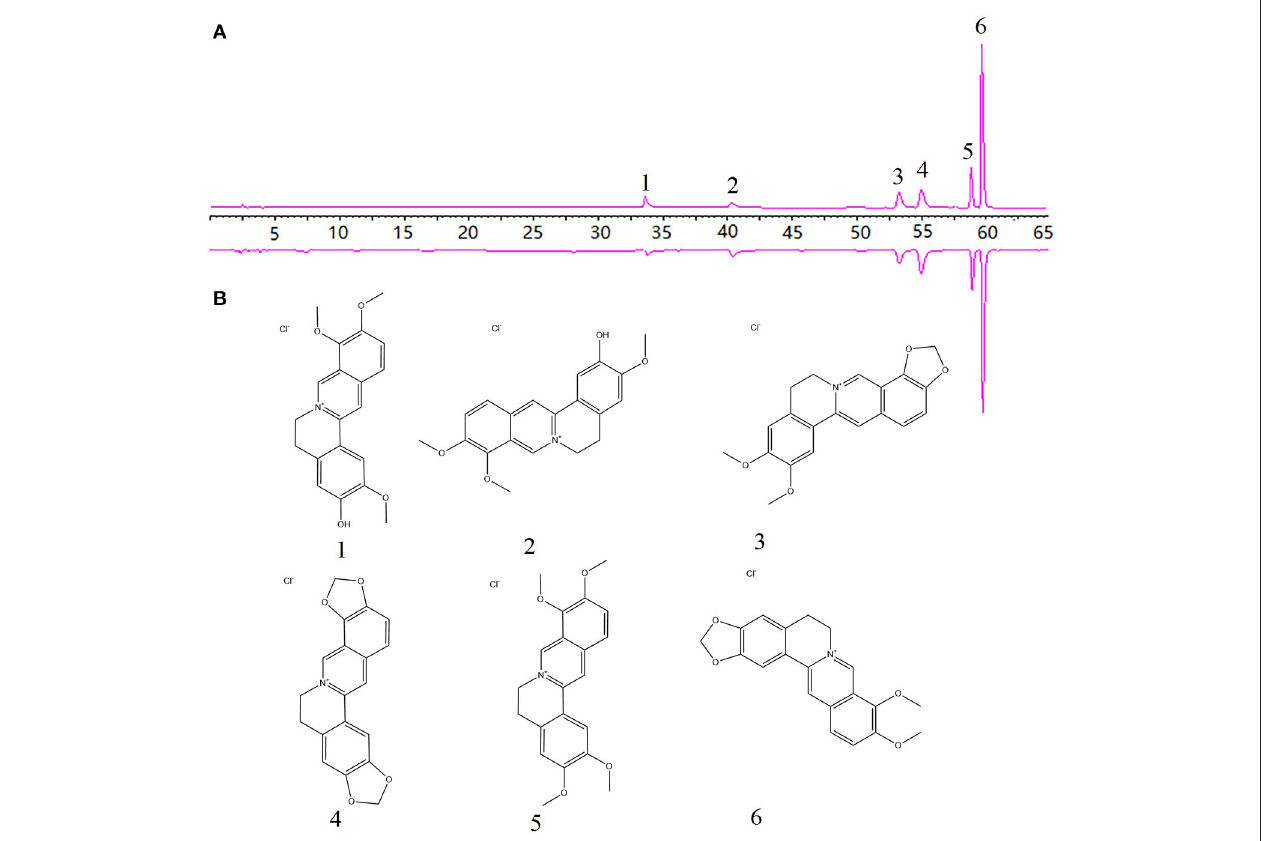
FIGURE 2 | The chromatogram of 6 alkaloids from CR. (A) Reference solution. (B) Coptidis Rhizoma. (1 Jatrorrhizine hydrochloride; 2 Columbamine hydrochloride; 3 Epiberberine hydrochloride; 4 Coptisine hydrochloride; 5 Palmatine hydrochloride; 6 Berberine hydrochloride).